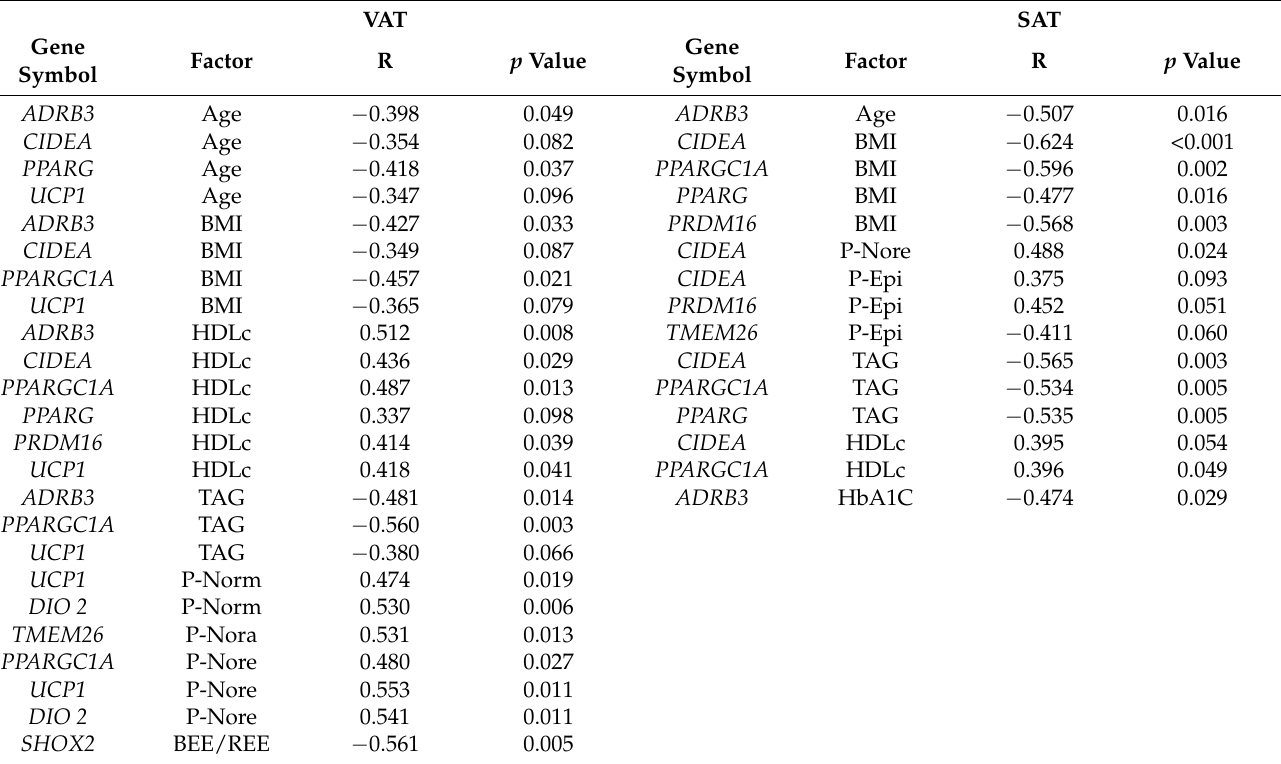
Table 3. Correlation analysis between mRNA expression of genes in VAT and SAT, and metabolic parameters of patients with PPGL with p value <